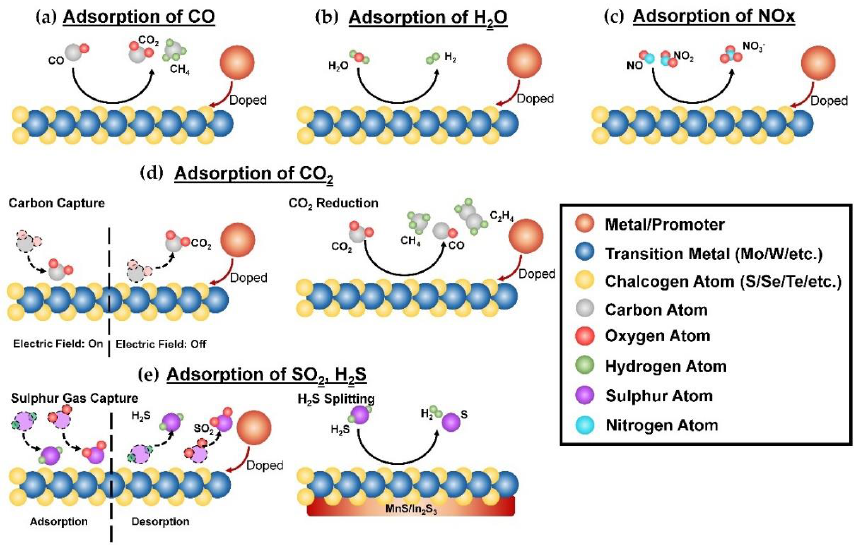
Figure 2. Schematic diagrams for the adsorption processes of ( a ) CO, ( b ) H 2 O, ( c ) CO 2 , ( d ) sulphur content, and ( e ) NO x with the use of TMDCs.